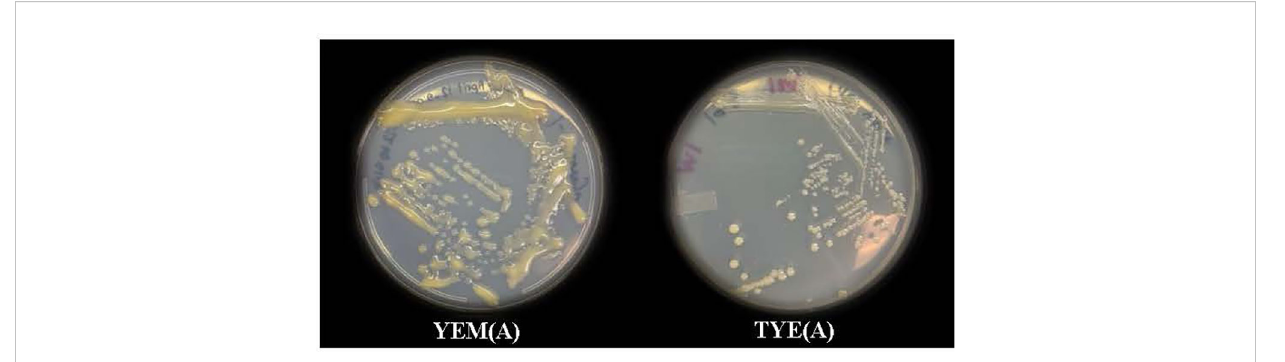
FIGURE 1 Growth of Devosia sp. (SL43 strain) in YEM(A) (Yeast Extract Mannitol Agar) and TYE(A) (Tryptone Yeast Extract Agar)